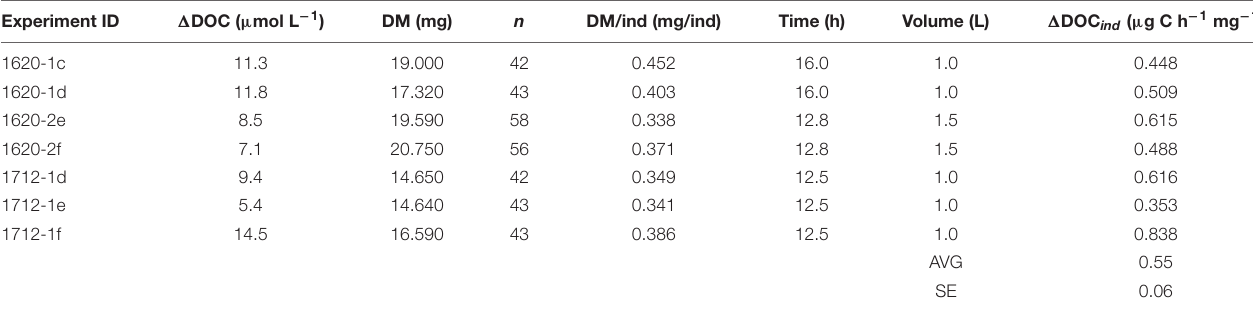
TABLE 2 | Zooplankton excreta production experiment: production of dissolved organic carbon ( (cid:49) DOC) by copepods during the incubations. Experiment